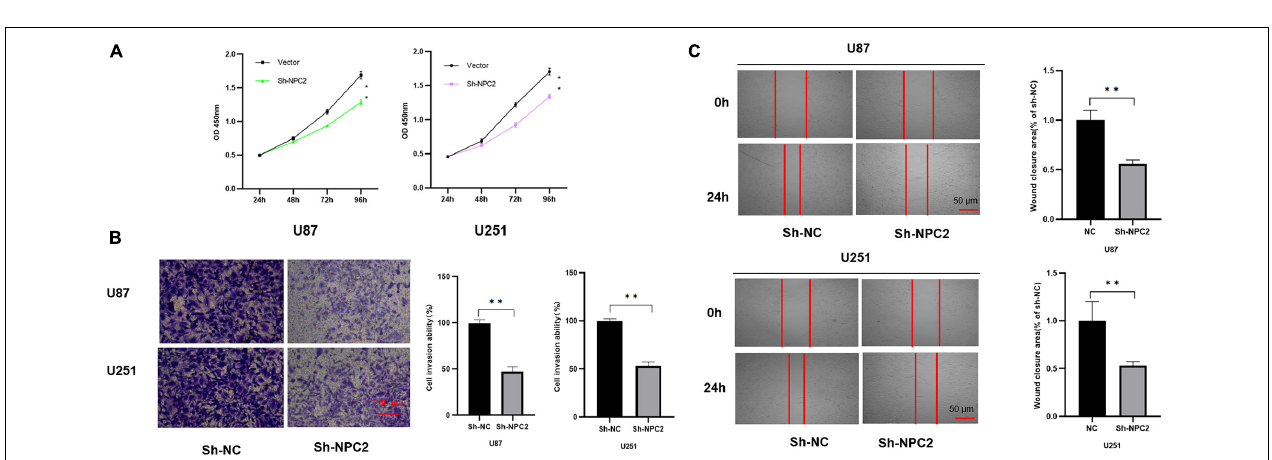
FIGURE 6 | NPC2 inhibits U87-MG and U251 cells proliferation, migration, and invasion in vitro . (A) The effect of NPC2 knockdown on cell growth of U87-MG and U251cells detected by the CCK-8 assay. (B) The invasive and migration capacities were detected in U87-MG and U251 cells transfected with sh-NPC2 using transwell assays. (C) Silencing NPC2 attenuated wound closure corroborated in U87-MG and U251. The error bars indicate the mean ± SD ( n = 3), and each experiment was repeated at least three times. * p < 0.05, ** p < 0.01.